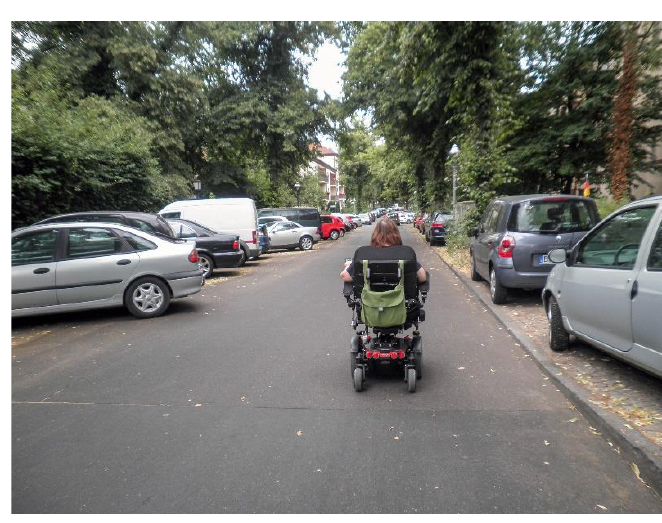
Figure 2. On the road with the PWC.